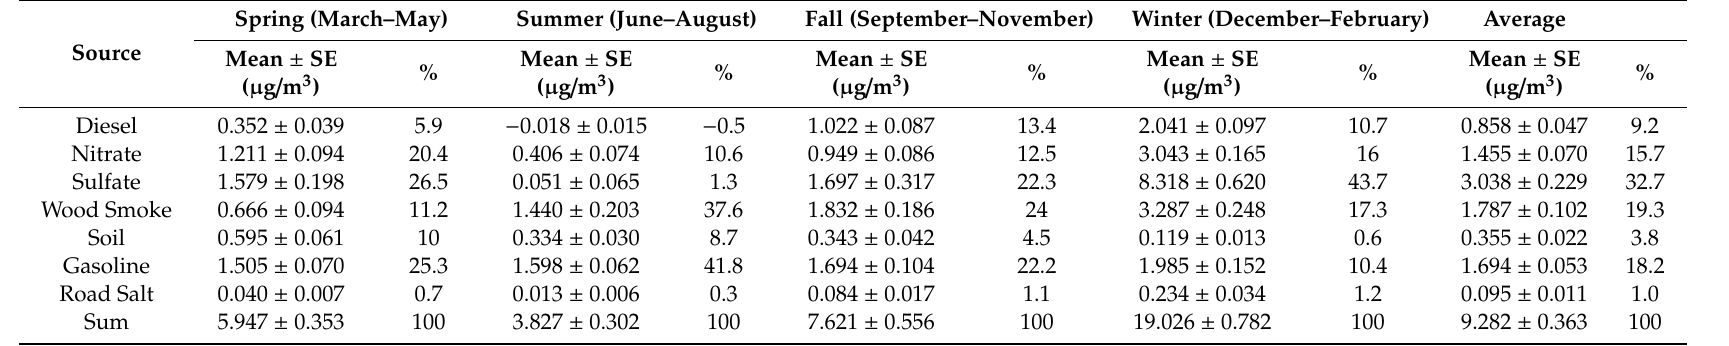
Table 6. Annual and seasonal average source contributions. (SE—standard